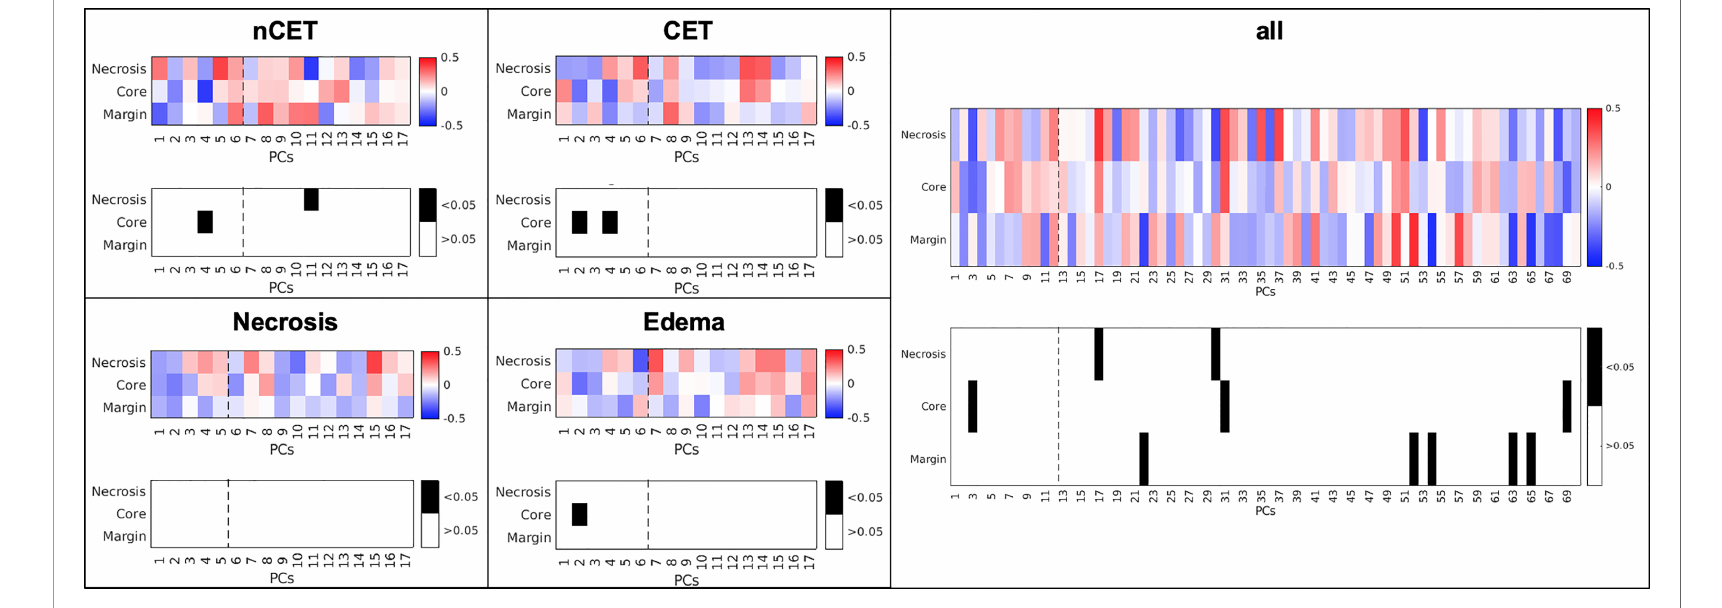
FIGURE 5 | Correlation between MRI-derived PCs and the BMDM/MG ratio in different sampling sites and in different MRI-derived tissues. The dotted line represents 80% of variance explained by PCs. nCET , non-contrast-enhancing tumor, CET , contrast-enhancing tumor, PCs , principal